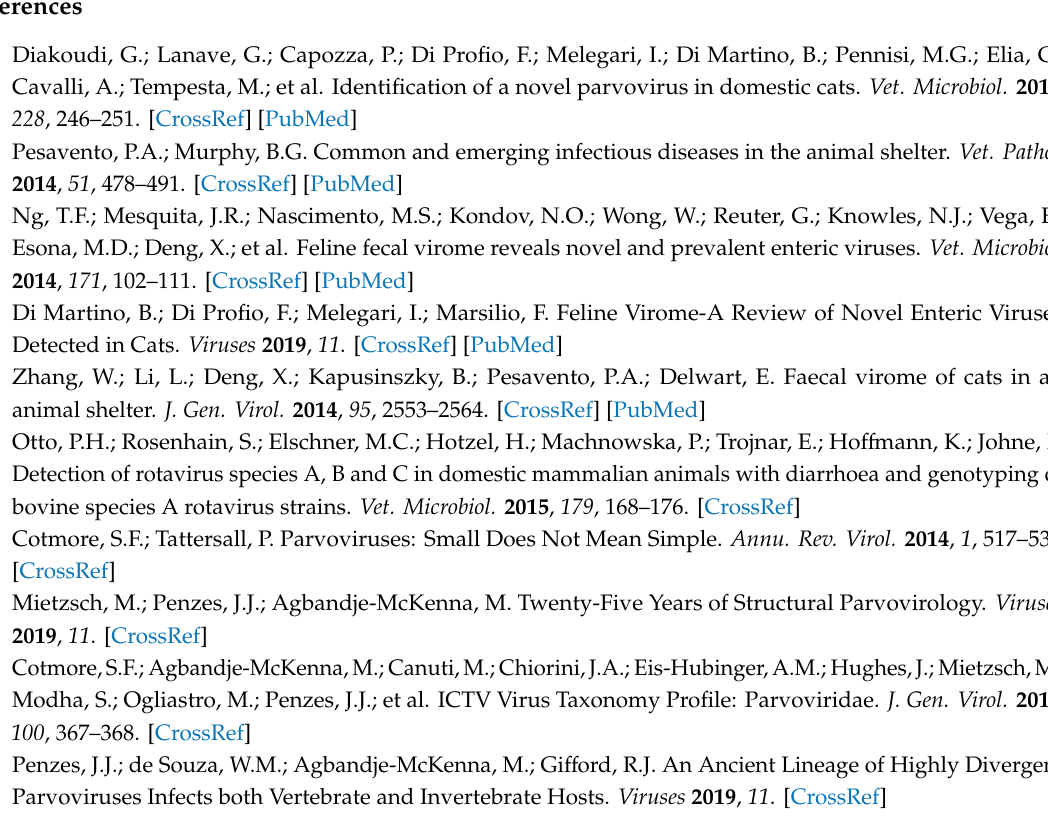
Table S1: Clinical signs and case definition ratings for all cats meeting case definition; Table S2: All fecal diagnostic test results for cats meeting case